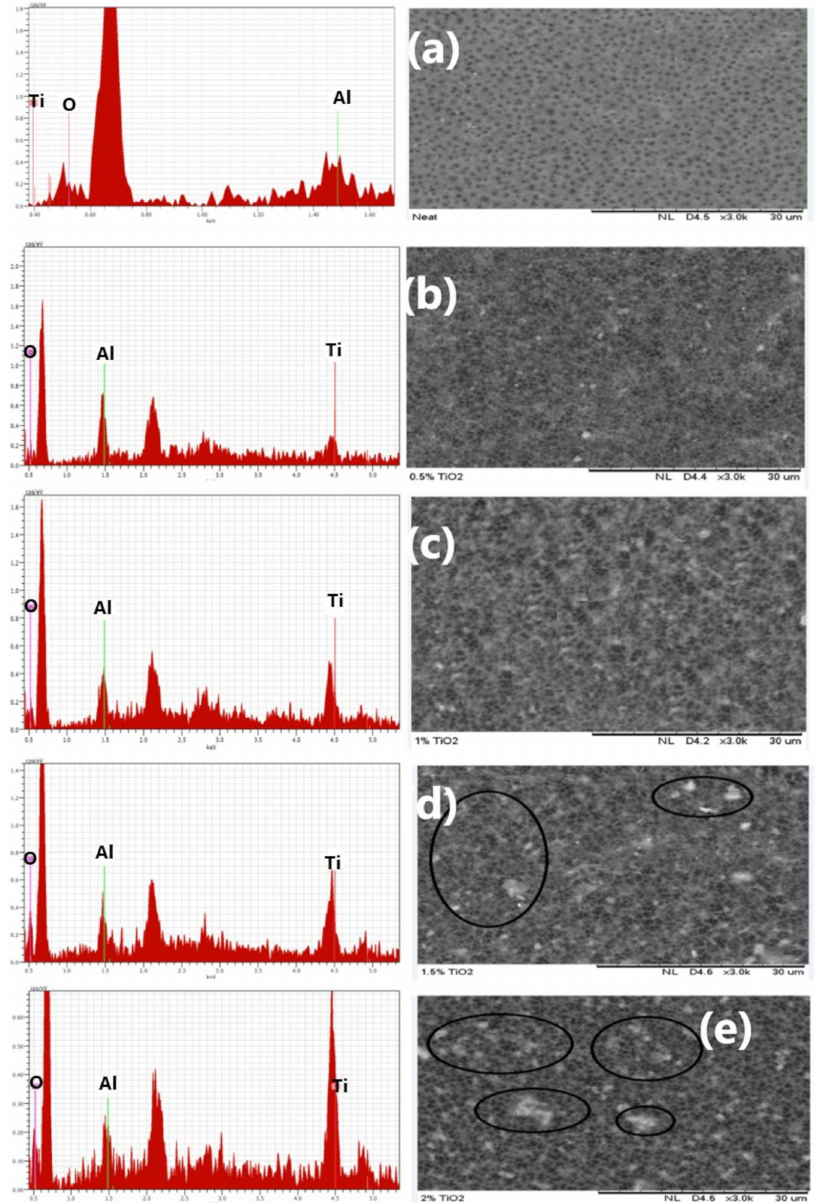
Figure 1. Matrix structure and elemental constituents of ( a ) neat TiO 2 , ( b ) 0.5 wt% TiO 2 , ( c ) 1.0 wt% TiO 2 , ( d ) 1.5 wt% TiO 2, and ( e ) 2.0 wt% TiO 2